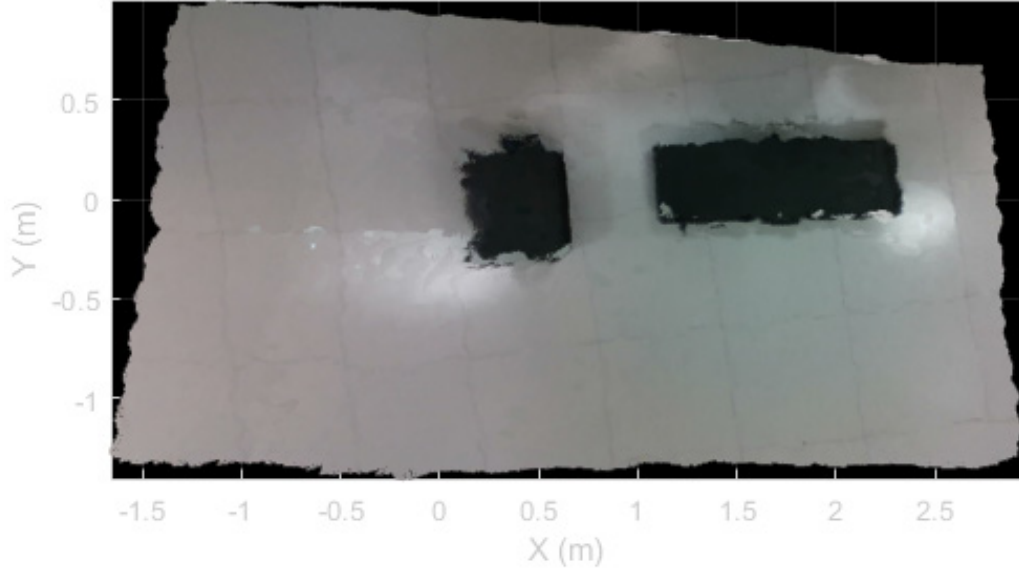
Figure 6. Three-dimensional scene reconstruction obtained via direct pose of pictures.